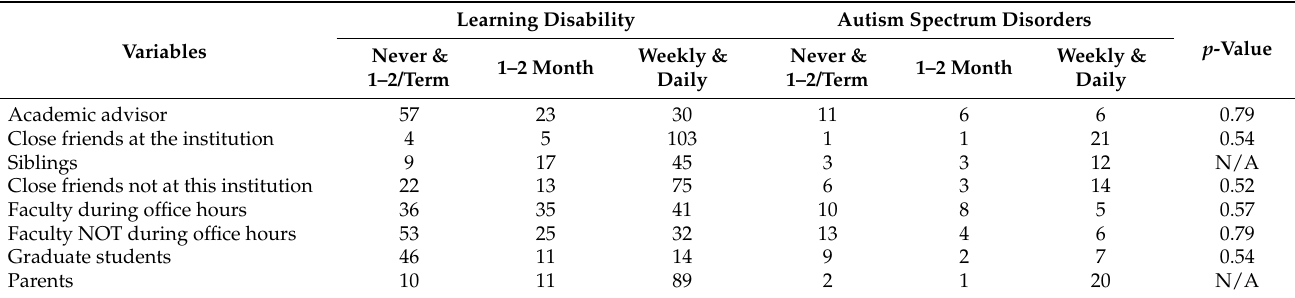
Table 4. Number of students with learning disabilities and autism spectrum disorders and their social and academic Interactions during their first-year of